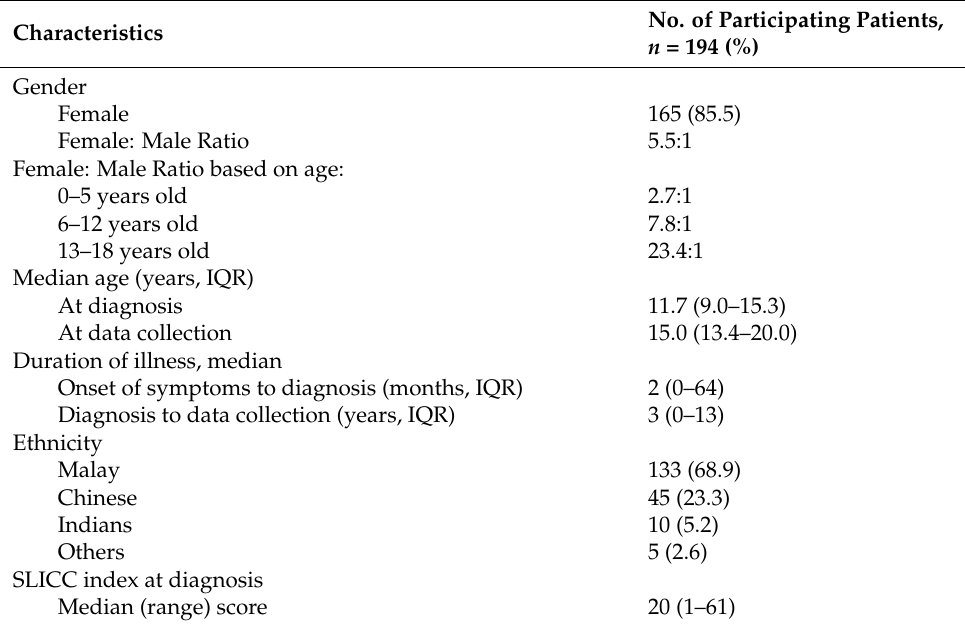
Table 1. Demographic characteristics of Malaysian children with SLE.